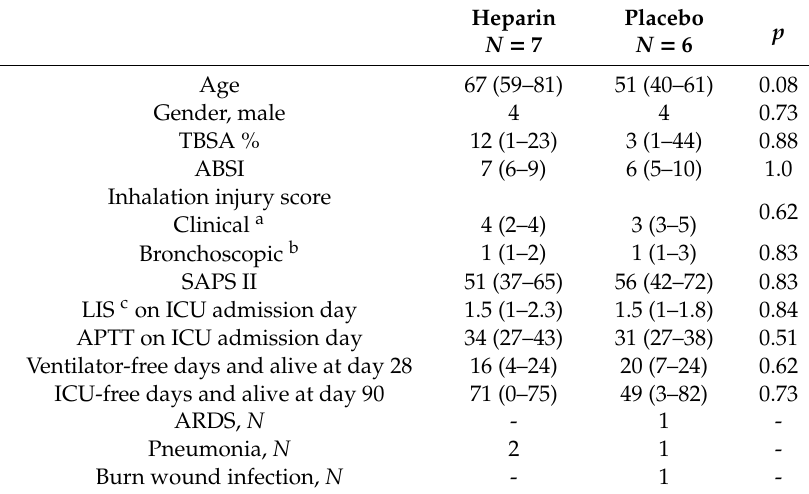
Figure 1. Consort diagram. Abbreviations. TBSA: total body surface area. N : number. Table 1. Demographic and baseline characteristics and clinical outcomes.